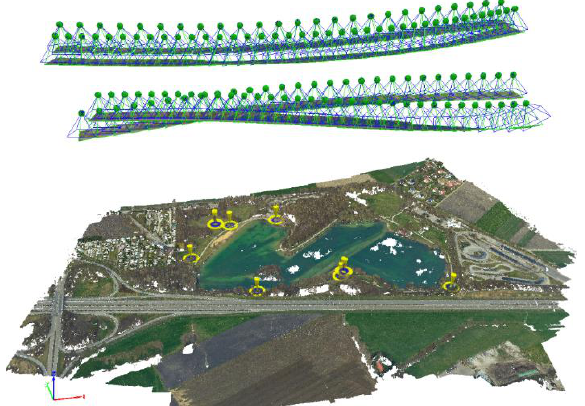
Figure 1. Study area Autobahnsee– a manmade freshwater lake near Augsburg, Germany.